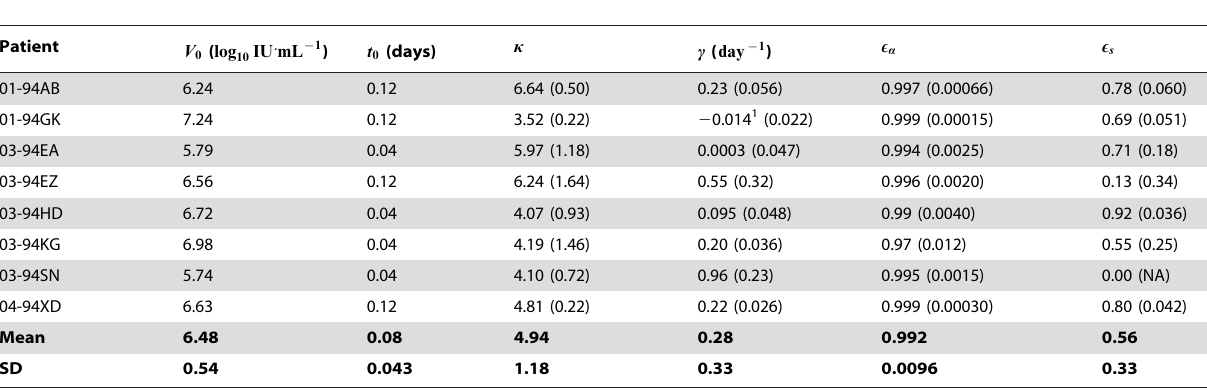
Table 2. Parameter values with standard errors in parenthesis estimated by fitting the long-term approximation to viral load data and assuming m ~ 1 d { 1 , c ~ 22 : 3 d { 1 , d ~ 0 : 14 d { 1 , a ~ 40 d { 1 and r ~ 8 : 18 d { 1 .